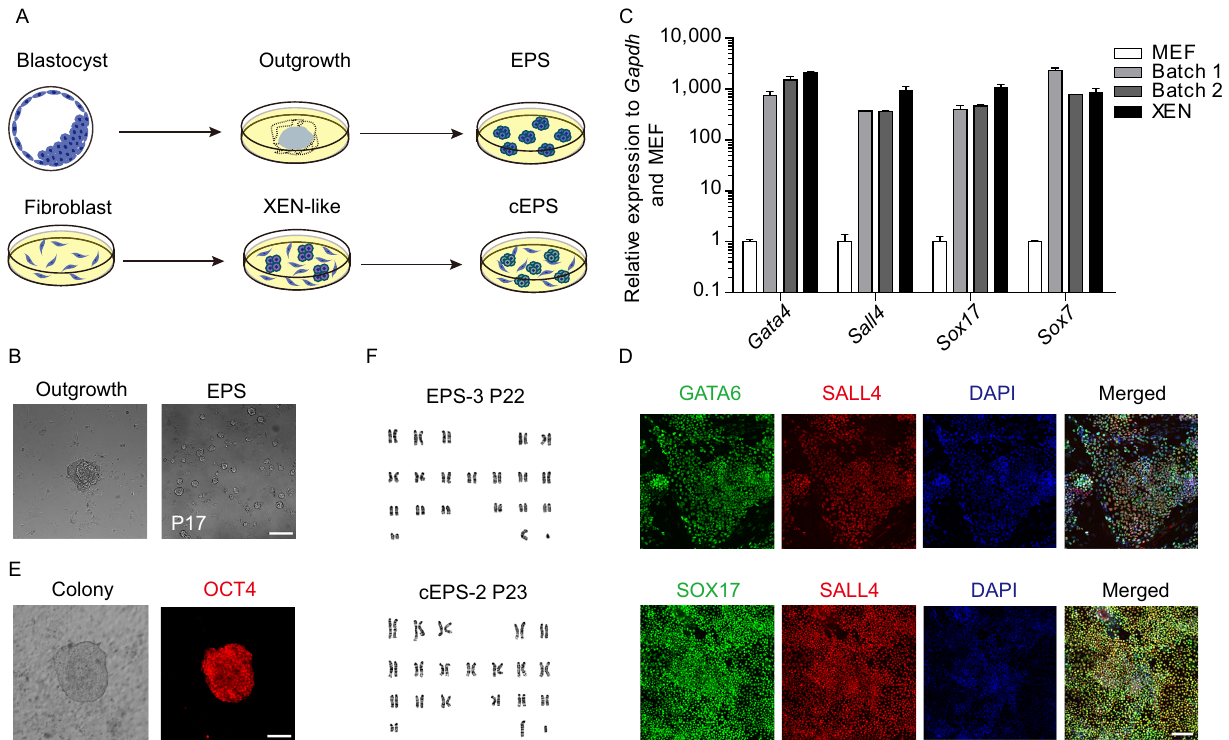
Figure 1. Generation of NOD- scid Il2rg − / − extended pluripotent stem cells. (A) Schematic of two approaches used for generating NOD- scid Il2rg − / − extended pluripotent stem cells: de novo derivation from blastocysts (upper panels) and chemical reprogramming from embryonic fi broblasts (lower panels). (B) Phase-contrast images of de novo derived outgrowth and EPS colonies for 17 passages in LCDM medium. Scale bars, 100 μ m. (C) qRT-PCR analysis of XEN marker genes expression during the chemical induction process (day 16). Error bars indicate SEM ( n = 2). (D) Co-immunostaining of XEN marker genes during the chemical induction process (day 16). Upper panels: GATA6 and SALL4; lower panels: SOX17 and SALL4. Scale bars, 100 μ m. (E) Immuno fl uorescence of OCT4-positive primary colonies at the end of the chemical induction (day 40). Scale bars, 100 μ